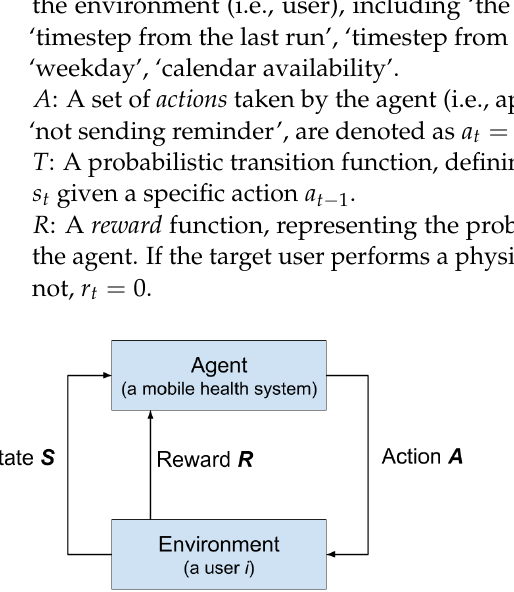
Figure 2. The interaction flow of our RL model, where the agent representing the smartphone health application and the environment is a user (Please note that the term reward is a specific entity in the MDP model. In our case, it indicates whether a physical activity is performed after the user receives a reminder sent by the RL